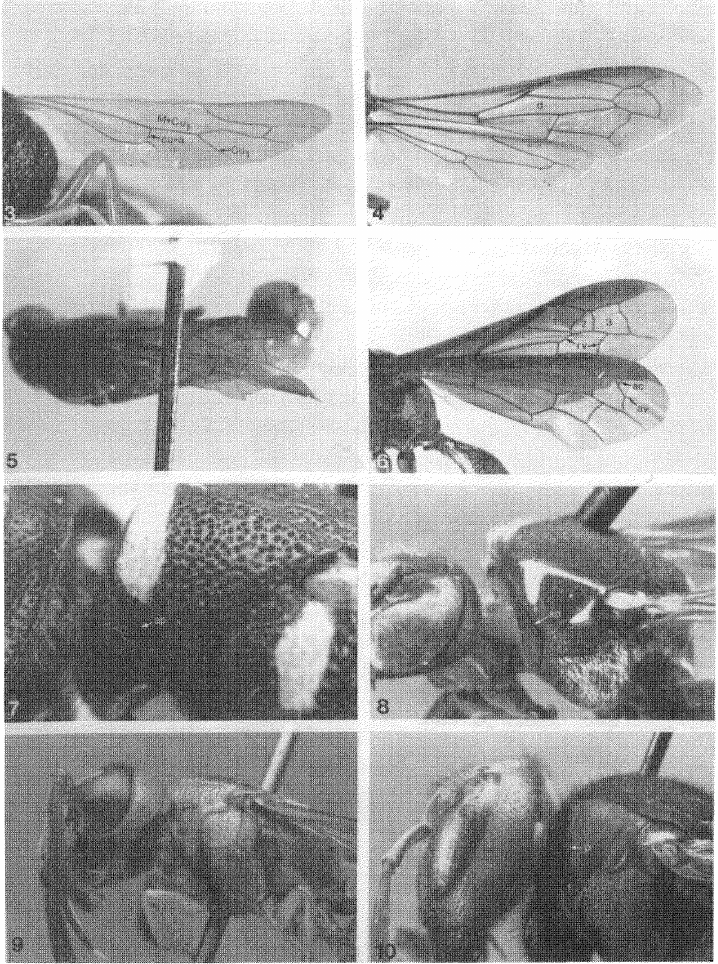
Figs. 3-10. 3. Gayella araucana, 7}(. Hindwing. 4. Paragia decipiens aliciae, 4)<. Wings. 5-6. Wings, 6X. 5. Paramasaris brasiliensis. 6. P. richardsi. Submar- ginal cells are numbered. 7-10. Lateral view of pronotum. 7. G. araucana, 17X. 8. Euparagia scutellaris, 10X. 9. Ischnocoelia robusta, 6X. 10. Vespa affinis, 5. ac: adventitious cell; ap: anterior pronotal carina; av: adventitious vein; d: discal cell;./? pronotal fovea; p: ptonotal carina; rv: recurrent